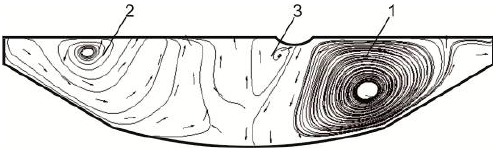
Figure 2. The trajectories of the melt flow in the bath vertical section along the Y axis, disregarding the heat-gravitational convection.